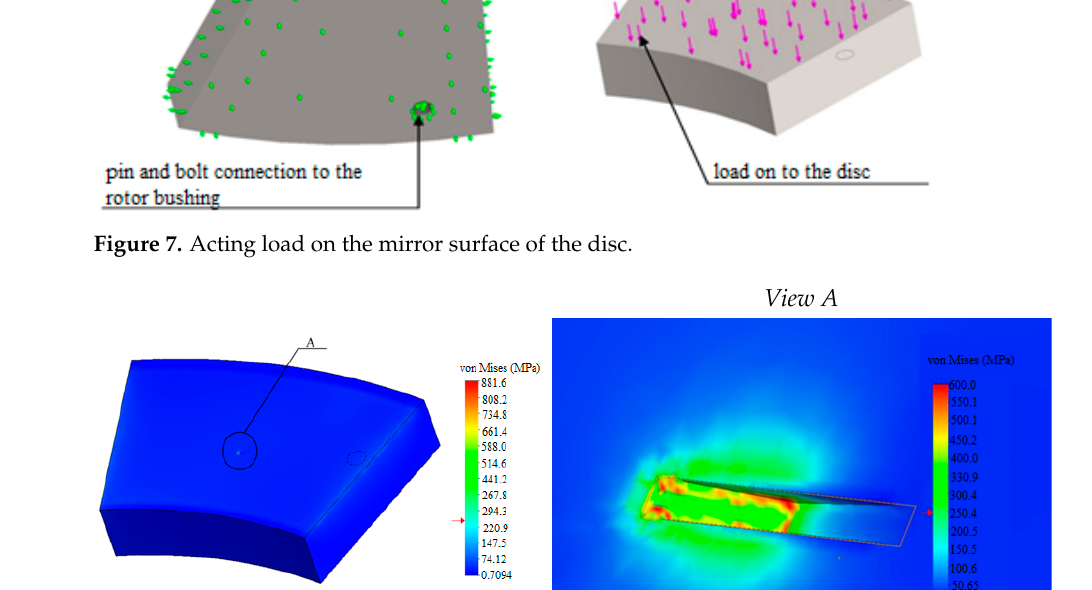
Figure 9. Change in stresses along the length of defect No. 1. According to the obtained results, the average stress along the mirror surface of the disc comprises 50 MPa. In the defect location zone, the maximum stress is 625 MPa and the average stress is 520 MPa. These values exceed the strength limit (470 MPa, according to DSTU 9182:2022), yield strength (245 MPa, according to DSTU 9182:2022), and permissible stresses for rotating parts (233 MPa, according to IEC 60034-33:2022) [18,20].